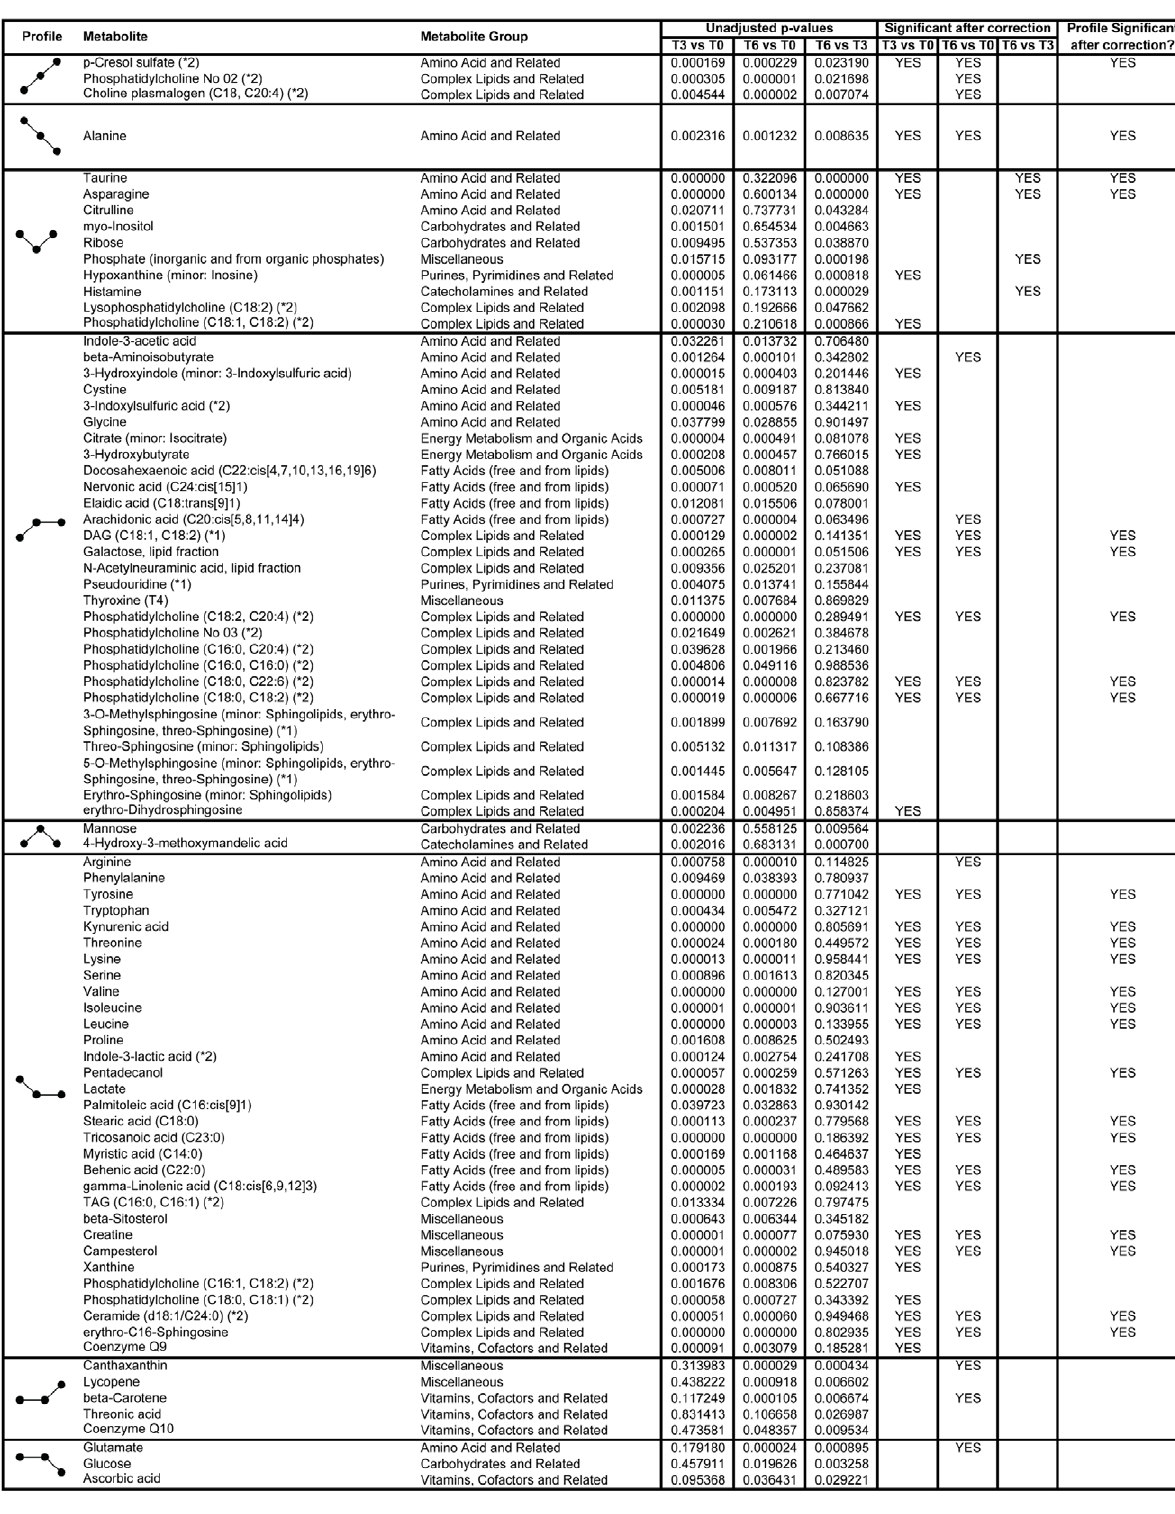
Figure 1. Various profiles for metabolites that change significantly at some point following RYGB. A profile is characterized by 3 dots, which represent T0 (prior to RYGB), T3 and T6 (post surgery). An angled slope between two time points indicates a significant change (p , 0.05) and a flat slope between two time points indicates non-significant changes. Based on data derived from the mixed-effects ANOVA using all 14 subjects together. (*1): Structure annotation is based on strong analytical evidence (combinations of chromatography, mass spectrometry, chemical reactions, deuterium-labeling, database and literature search, as well as comparisons to similar/homologue/isomeric reference compounds). (*2): Metabolite exhibits identical qualitative analytical characteristics (chromatography and mass spectrometry) compared to status (*1). Further structural and analytical investigations of this metabolite - also in comparison to structurally identified or status (*1) metabolites - are still pending.